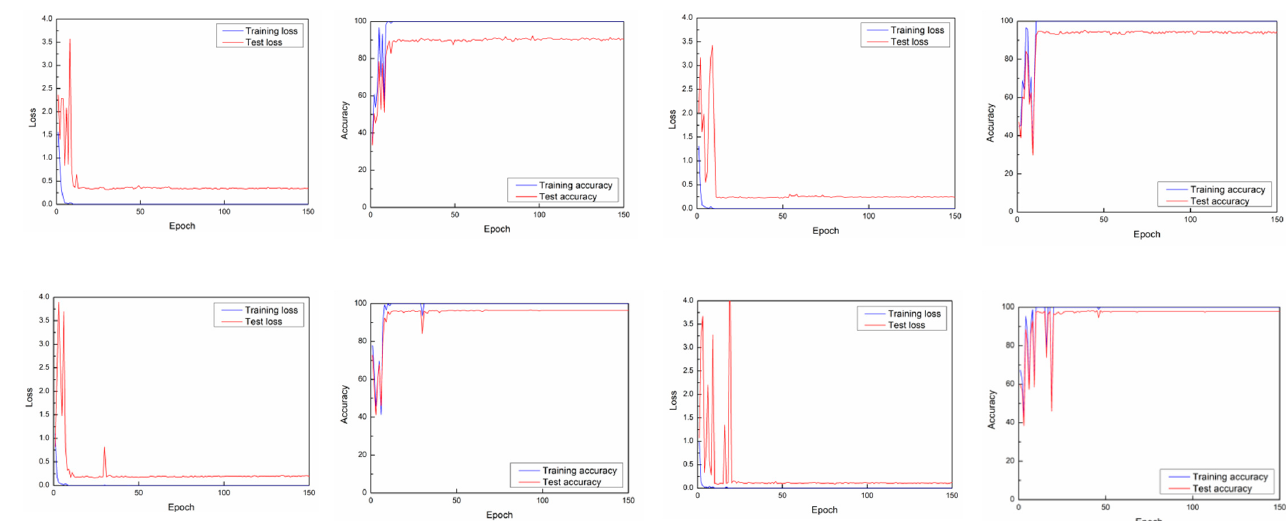
Figure 4. Learning curves and losses of training raw data (the size of training data is